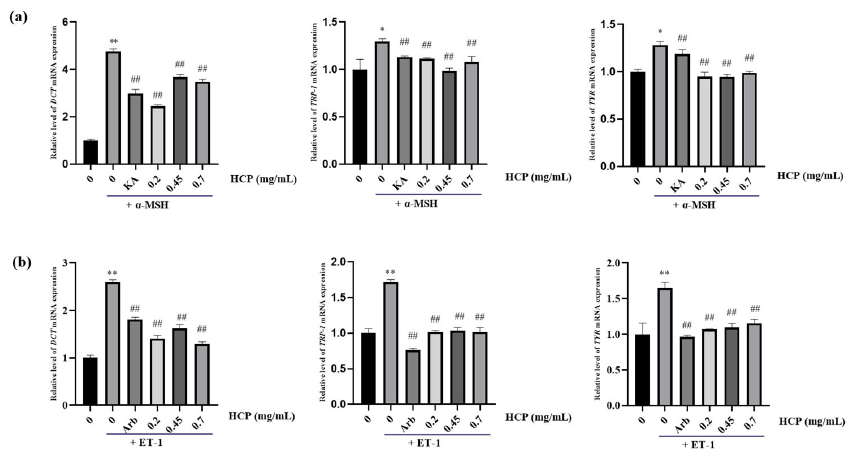
Figure 5. Effect of HCP on mRNA expression of tyrosinase ( TYR ), tyrosinase related protein 1 ( TRP-1 ) and dopachrome tautomerase ( DCT ). The cDNA for β - actin served as the internal